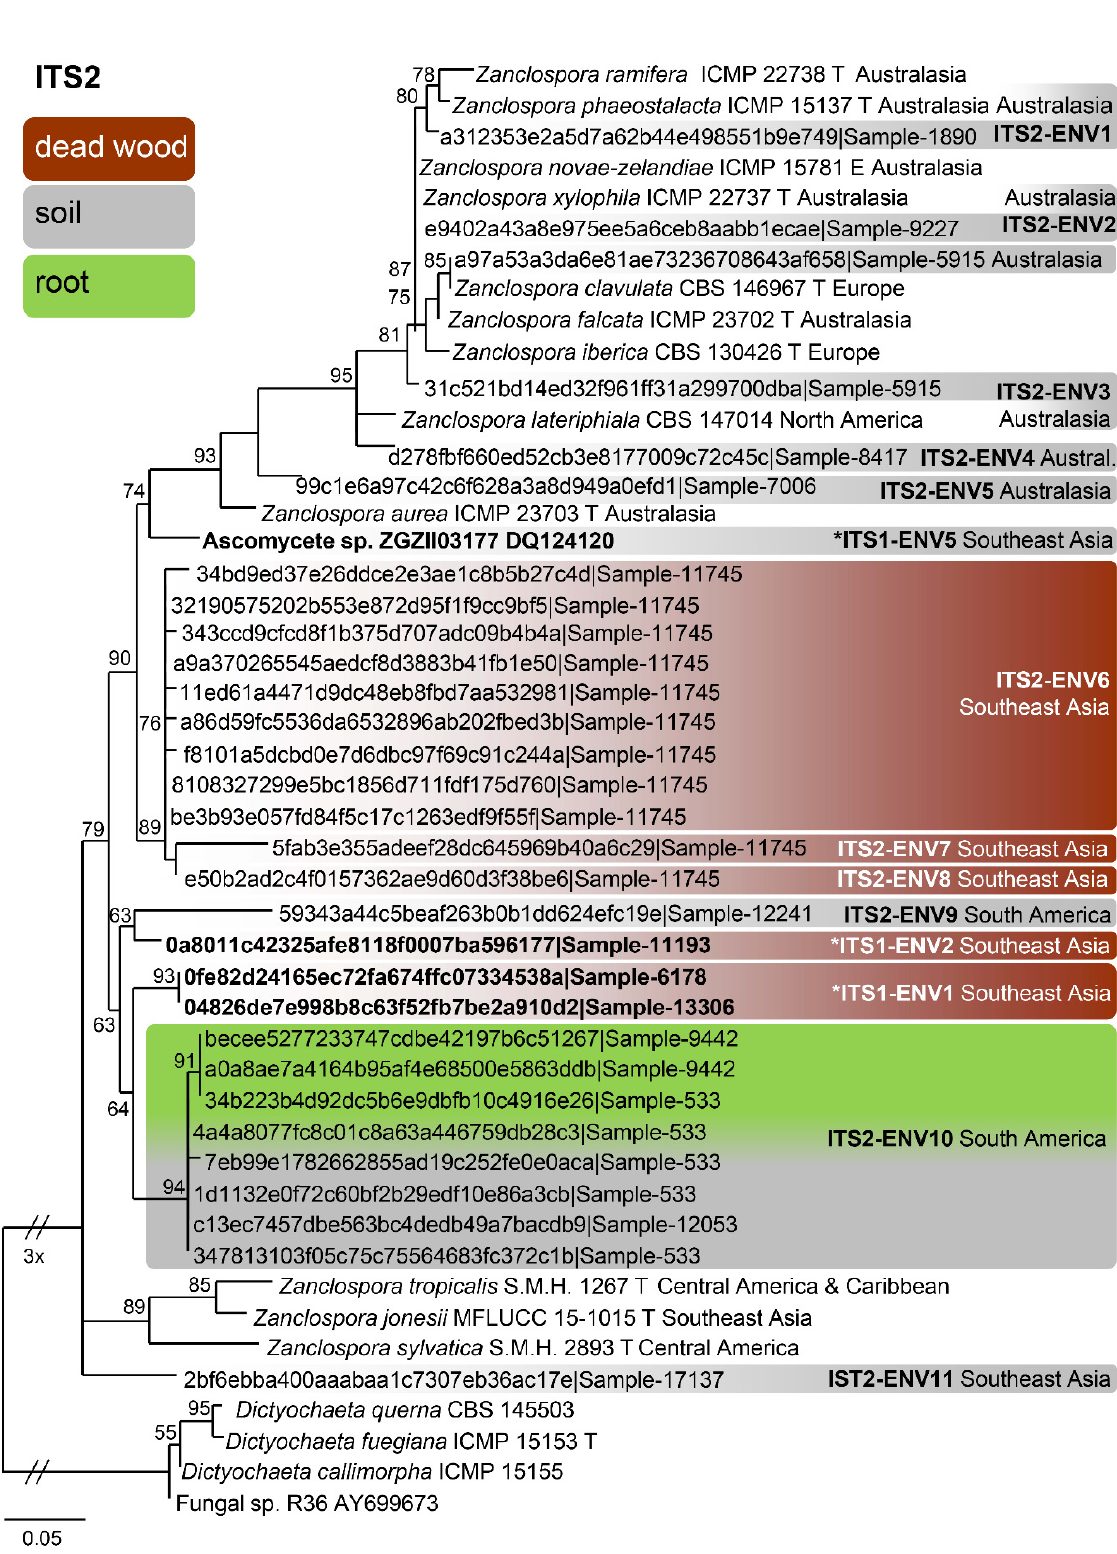
Figure 6. Phylogenetic relationships among Zanclospora species and related ITS2 environmental sequences deposited in the GlobalFungi database. The titles of sequences contain the sequence and sample codes taken from GlobalFungi. Branch support (ML) is retained at the nodes. Environmental samples in bold indicate those sequenced for the whole ITS region. Habitat of the environmental sequences is indicated by brown, grey and green boxes corresponding to dead wood, soil or roots. Asterisk (*) indicates phylotypes that can be linked with phylotypes defined by the ITS1 marker.